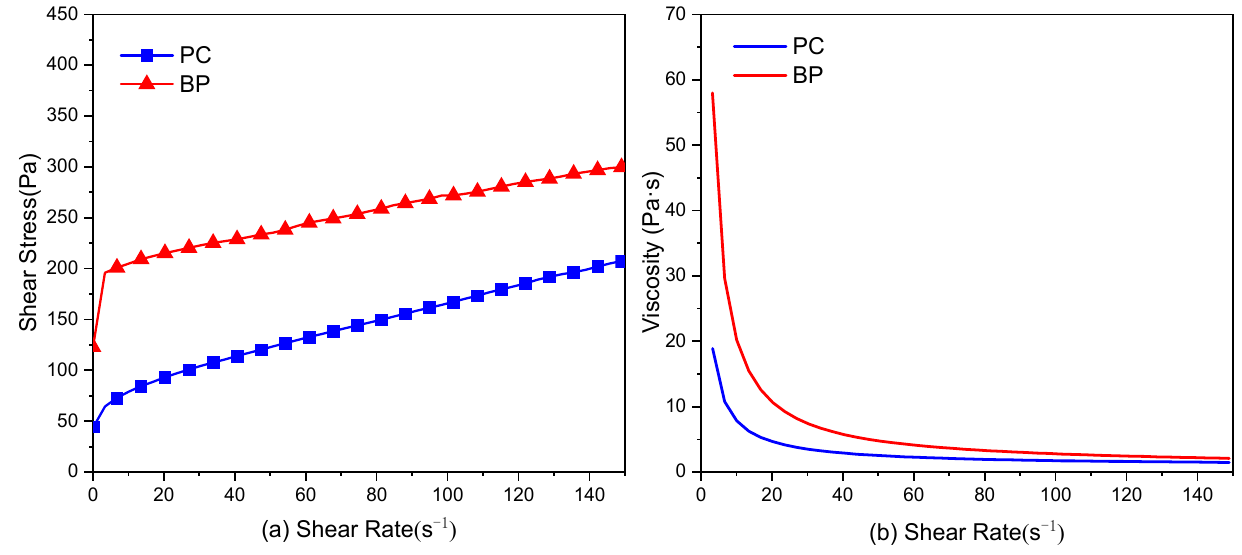
given in discussion.